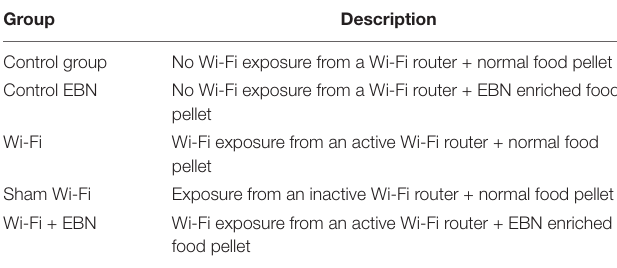
TABLE 1 | Description of experimental group.